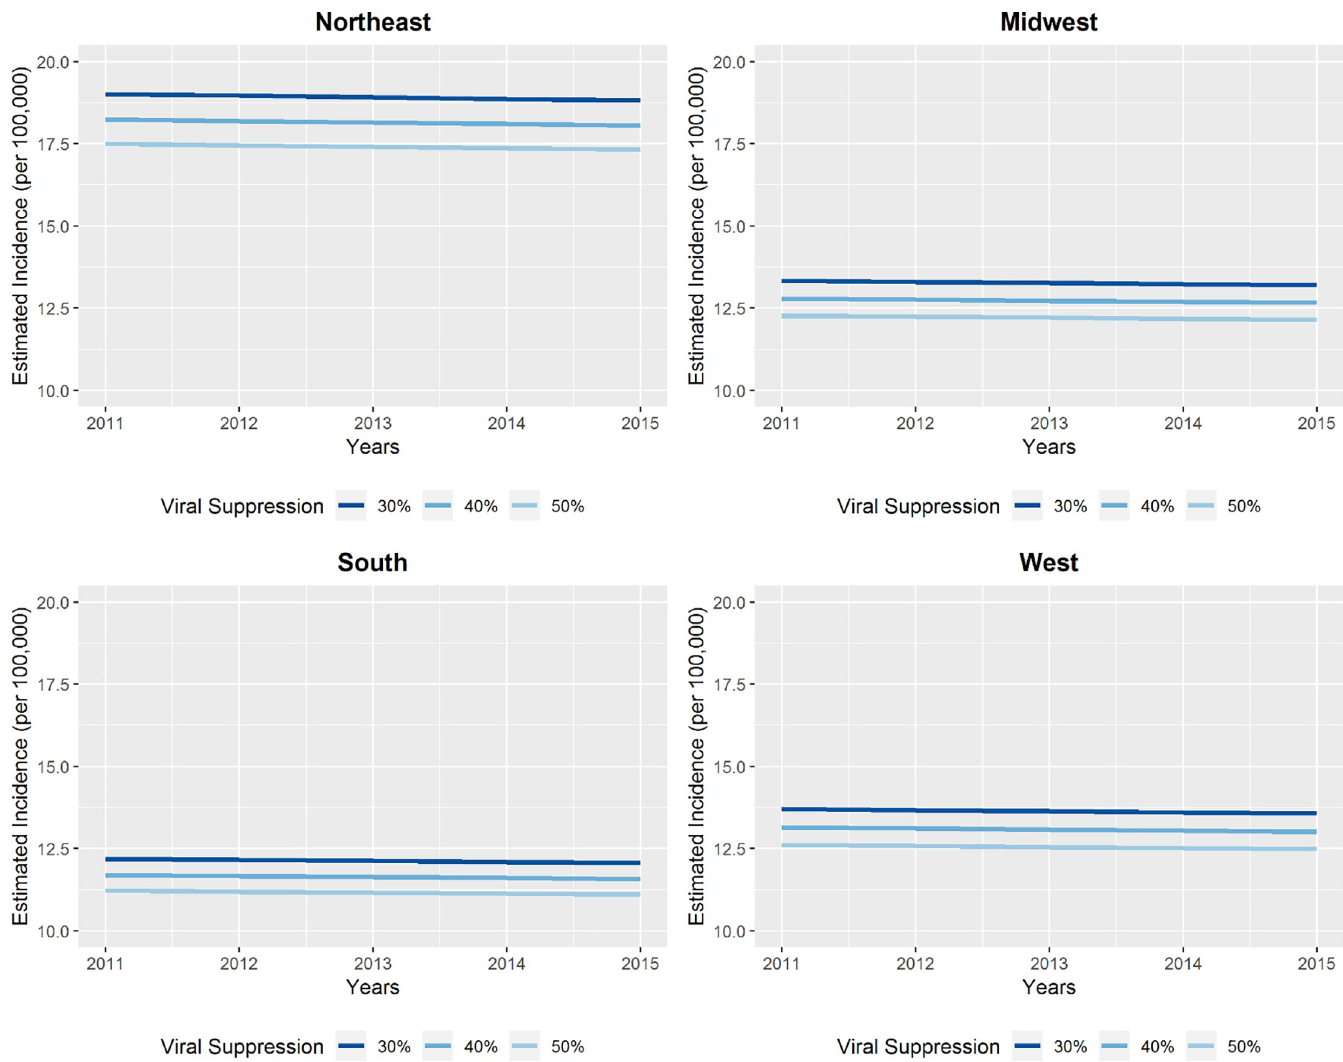
Fig 3. Fitted HIV incidence rate by viral suppression in previous year (%) and U.S. region, 2011–2015. Fitted HIV incidence rate determined using a multivariable mixed-effects Poisson regression model including all variables in Table 3, fixed effects for year and 2010 HIV incidence rate and a random